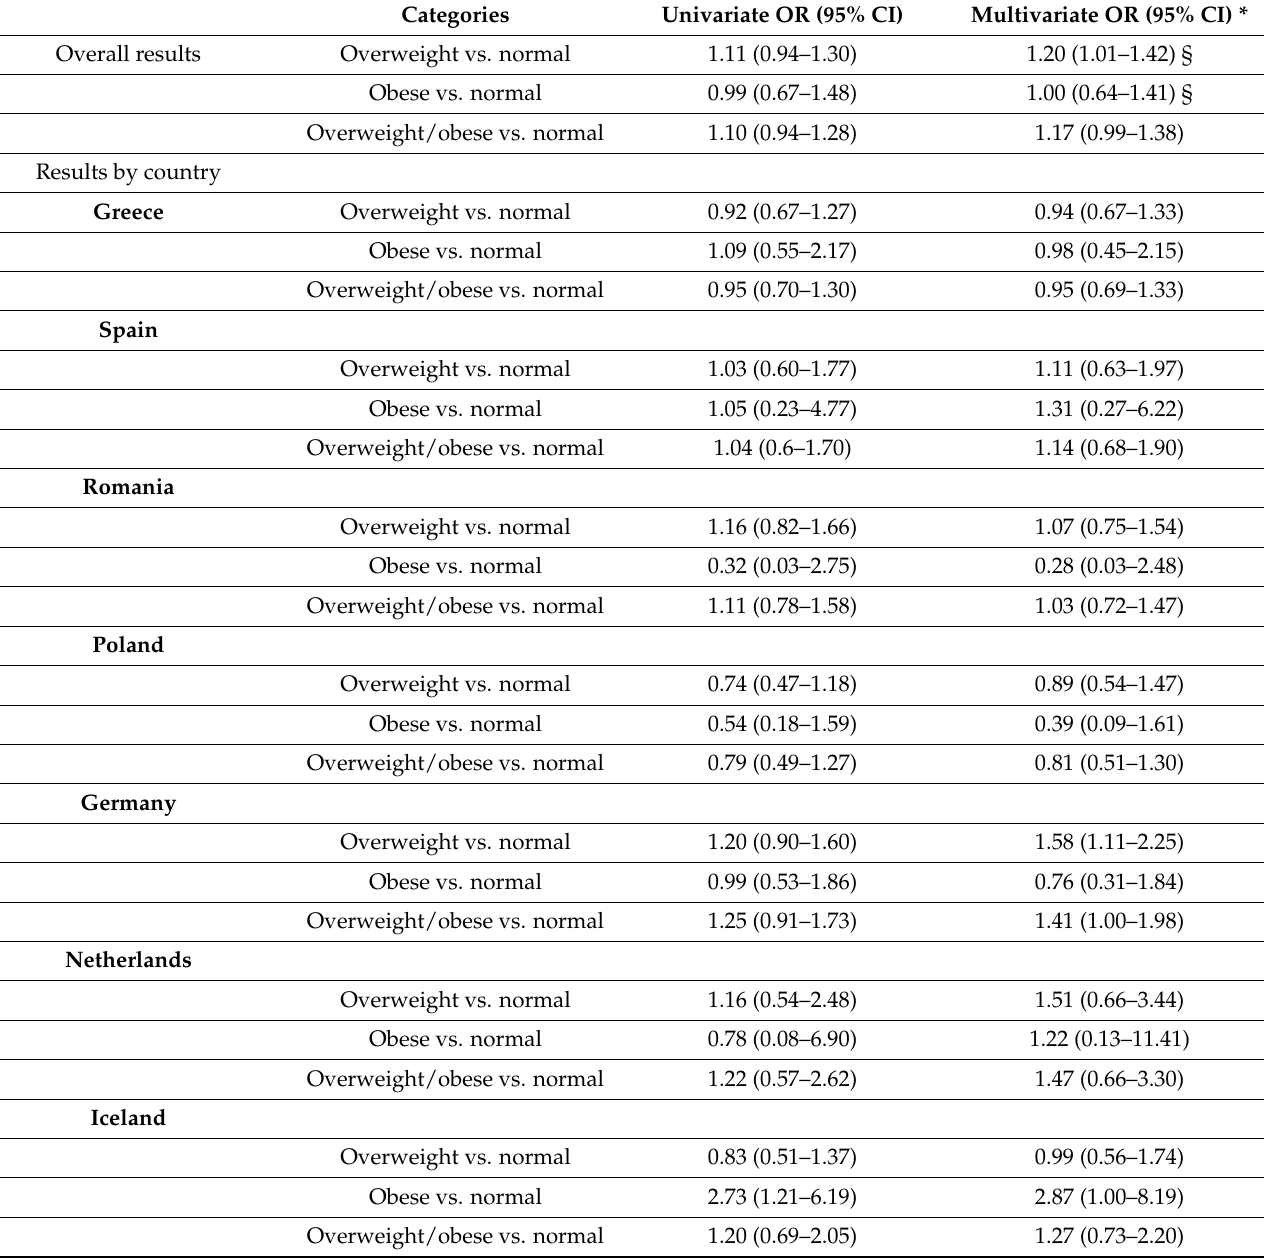
Table 2. Results of complex samples and univariate and multivariate logistic regression analyses for the association between cyberbullying victimization and body mass index (BMI) status (obese, overweight, overweight/obese vs. normal weight), overall and by